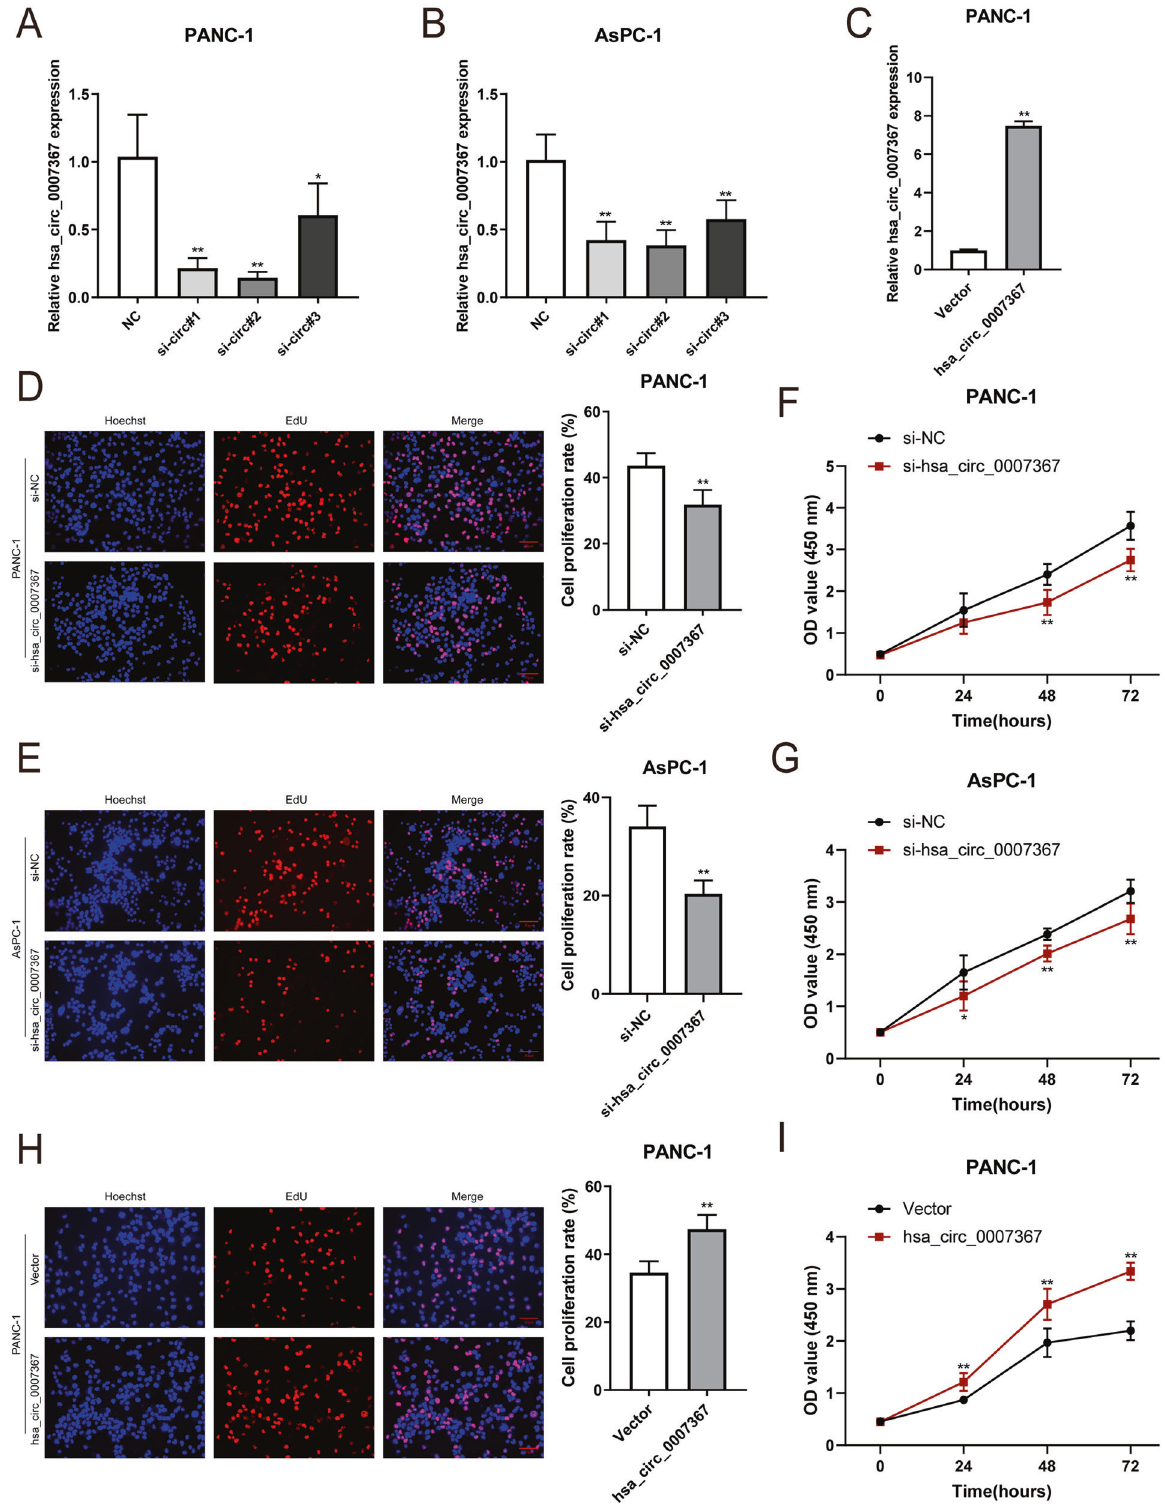
Fig. 2 Hsa_circ_0007367 promotes the proliferation of PDAC cells in vitro. A – C The expression of hsa_circ_0007367 in PANC-1 and AsPC-1 cells was analyzed by qRT-PCR after treated with three siRNAs ( A , B ) and transfected with hsa_circ_0007367 plasmid ( C ). D – I Cell proliferation was detected by EdU ( D , E ) and CCK-8 ( F , G ) assays in PANC-1 and AsPC-1 cells by knockdown of hsa_circ_0007367, and forced expression hsa_circ_0007367 in PANC-1 cells ( H , I ). All data are shown as the mean ± SD of at least three independent experiments. * p < 0.05, ** p < 0.01.